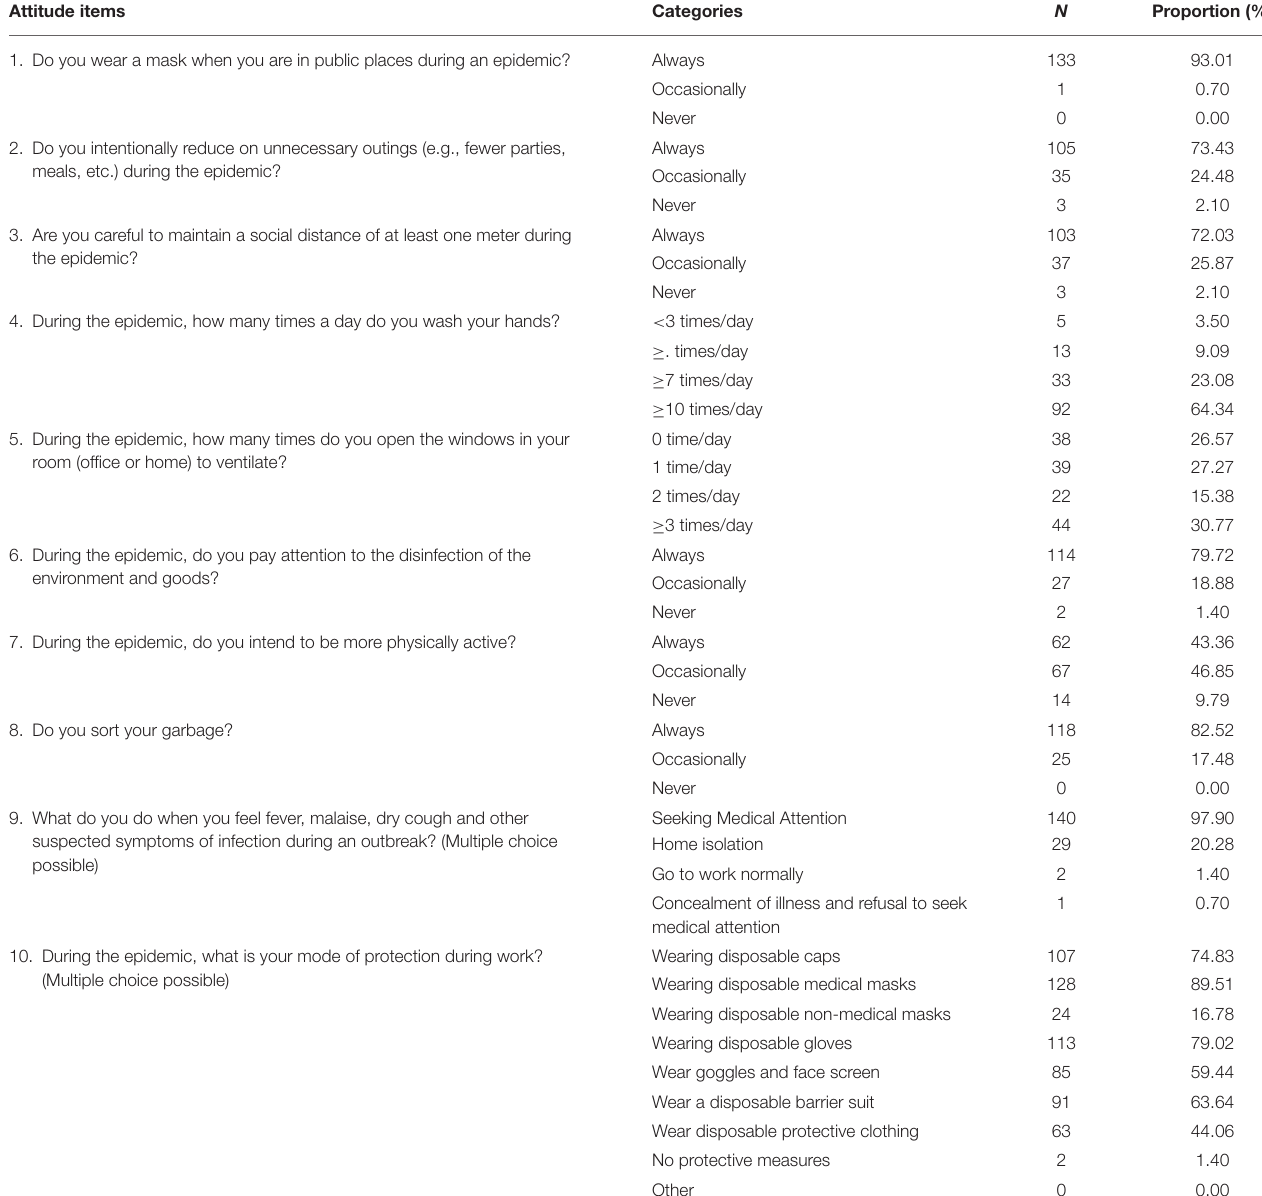
TABLE 3 | Responses of the participants to the practice items on the questionnaire ( n = 143). Attitude